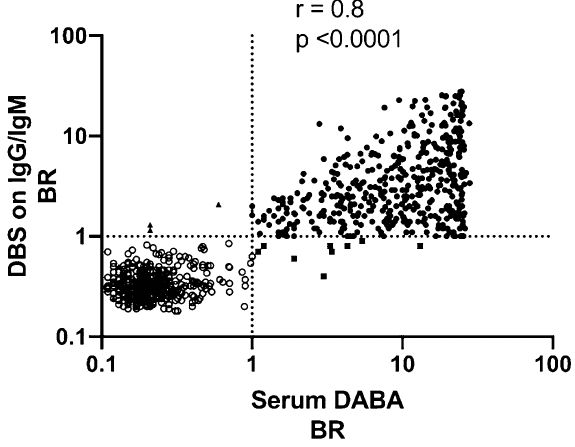
Figure 2. Correlation of BRs from S1 Ig assays using DBS eluates and Hybrid DABA assay using serum. Serum samples and paired DBS eluates from 439 sero-positive and 382 sero-negative individuals were assayed using hybrid DABA and the S1 IgG and IgM capture assays, respectively. BRs from DABA serum assay were plotted against those generated from the DBS eluate on a Log10 scale. Samples from sero-positive individuals are shown with filled circles and those from sero-negative individuals with empty circles. Correlation of the DBS and serum BRs with each assay is shown graphically along with the coefficient of correlation, r, and the significance, p, generated using PRISM software. The dotted lines represent the cut-off for each assay. Discordant samples, namely those that were DABA-positive and DBS-negative (n = 9) are represented by a square and samples which were DABA-negative and DBS-positive (n = 3) represented by a